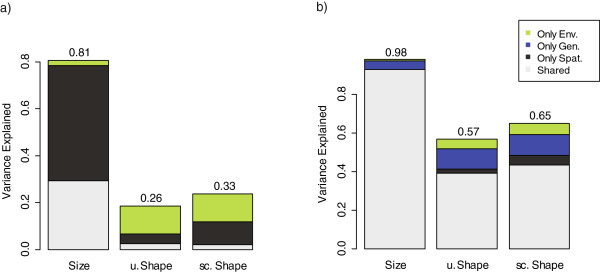
Relative explanatory power of environmental variation in SEVM regressions. Result of spatial regressions of size and uncorrected (u.) and size-corrected (sc.) shape variation on environmental variables (a) or on environmental and genetic variables (b). The proportion of variance explained exclusively by each set of predictors as well as the shared explained variance (i.e., combined effect of spatial and environmental in (a), combined effect of spatial, genetic, and environmental effects in (b)) is presented. The total variance explained is given on top of each bar. Note that in the shape analyses, the data depicted correspond to the overall variance explained (i.e., weighted sum of the variance explained in the regressions for each shape PC retained, see Methods, with weights determined by the proportion of variance explained by each shape PC).